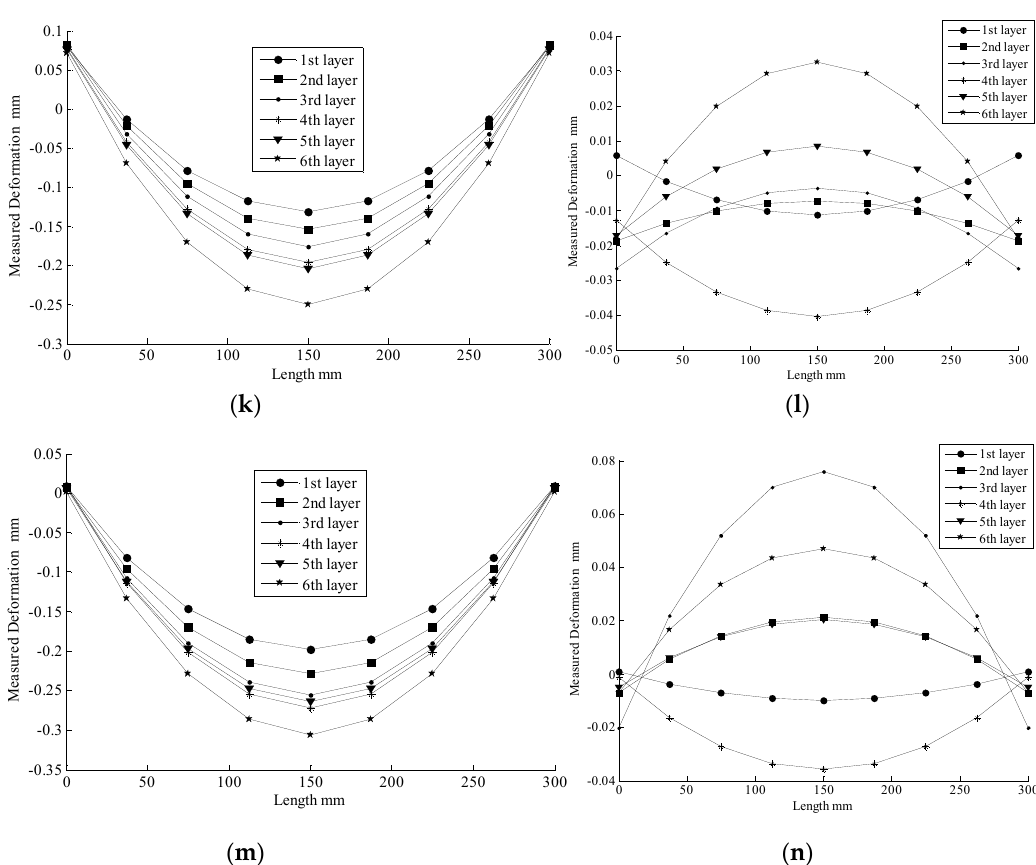
Figure 9. Deformation curves of cross-sections A-G for Specimen 1 and 2 at different process stage. ( a ) Cross-section A of Specimen 1; ( b ) cross-section A of Specimen 2; ( c ) cross-section B of Specimen 1; ( d ) cross-section B of Specimen 2; ( e ) cross-section C of Specimen 1; ( f ) cross-section C of Specimen 2; ( g ) cross-section D of Specimen 1; ( h ) cross-section D of Specimen 2; ( i ) cross-section E of Specimen 1; ( j ) cross-section E of Specimen 2; ( k ) cross-section F of Specimen 1; ( l ) cross-section F of Specimen 2; ( m ) cross-section G of Specimen 1; ( n ) cross-section G of Specimen